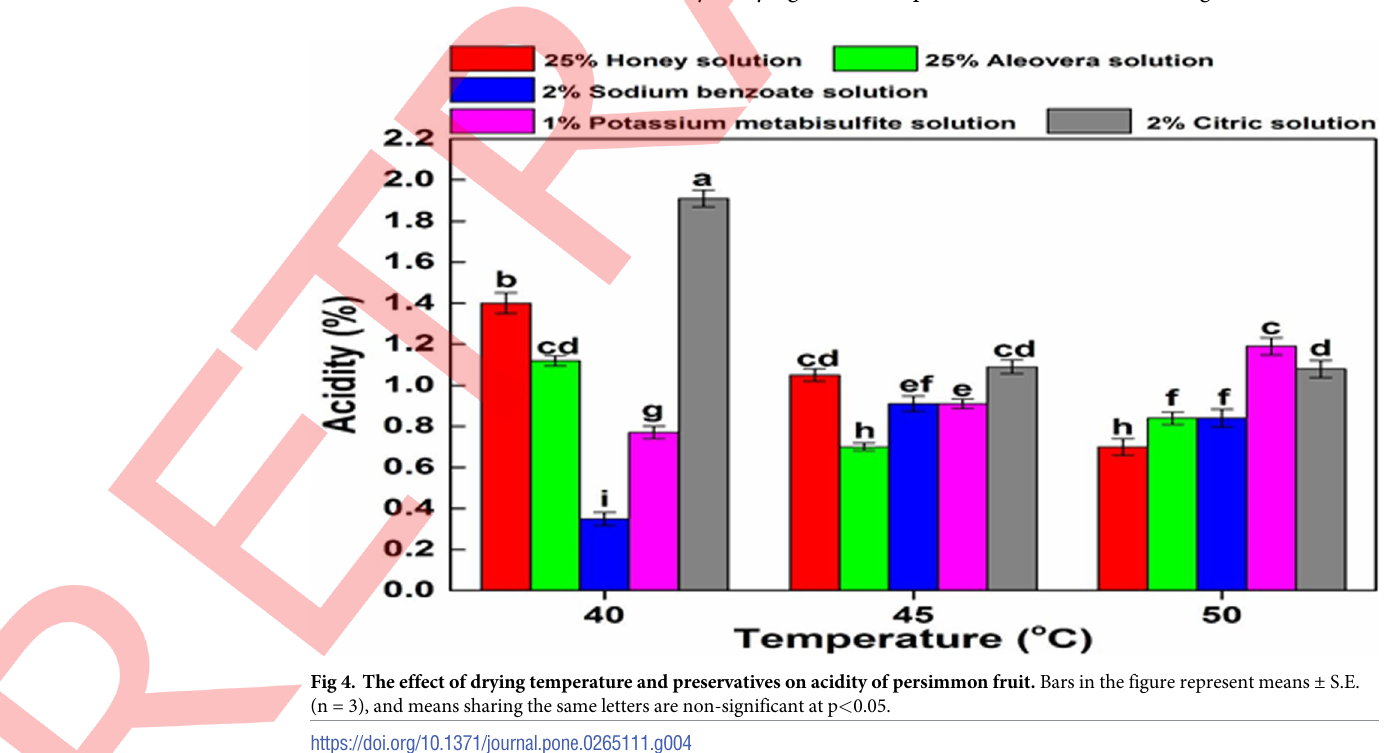
Fig 4. The effect of drying temperature and preservatives on acidity of persimmon fruit. Bars in the figure represent means ± S.E. (n = 3), and means sharing the same letters are non-significant at p <